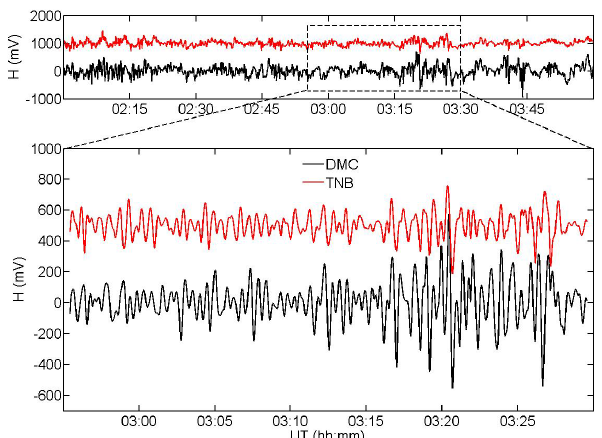
Fig. 6. A pulsation event observed on 10 February 2005, 02:00– 04:00UT, on the H component at DMC and TNB (top panel) and a detail of the 20–60mHz filtered signal (bottom